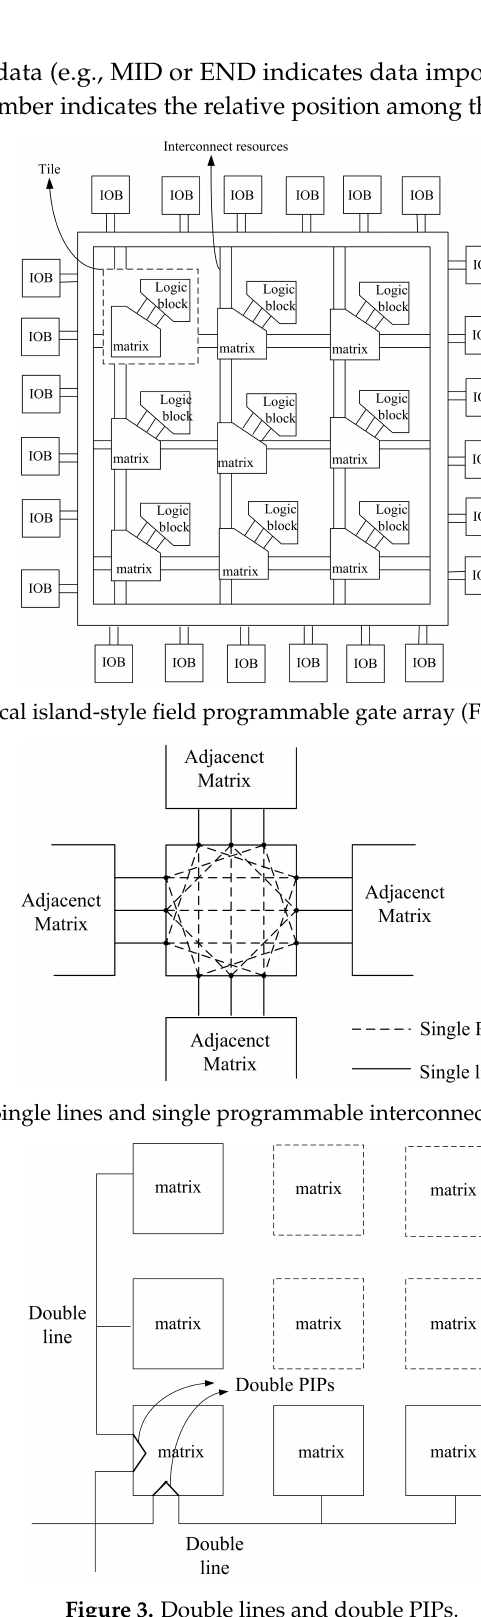
Figure 3. Double lines and double